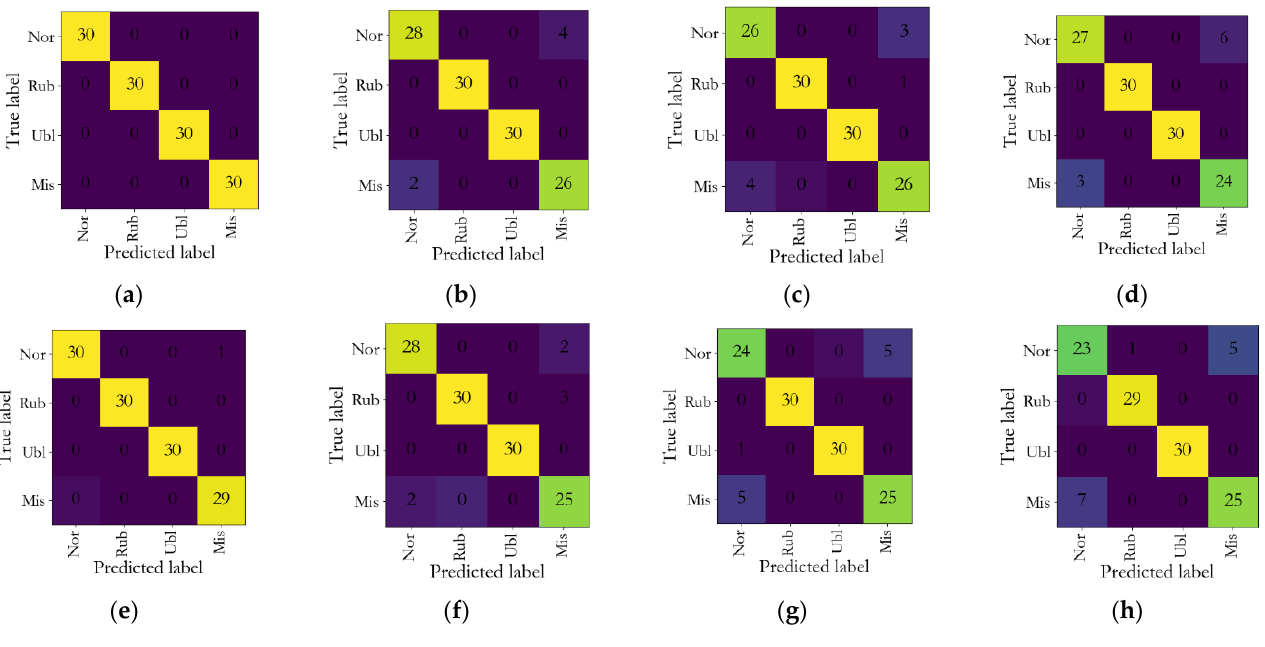
Figure 10. Confusion matrix diagram for different models: ( a ) IMFWPE-XGBoost; ( b ) IMFPE-XGBoost; ( c ) IMPE-XGBoost; ( d ) MSE-XGBoost; ( e ) IMFWPE-RF; ( f ) IMFPE-RF; ( g ) IMPE-RF; ( h ) MSE-RF. Table 2. Fault diagnosis results of different models.